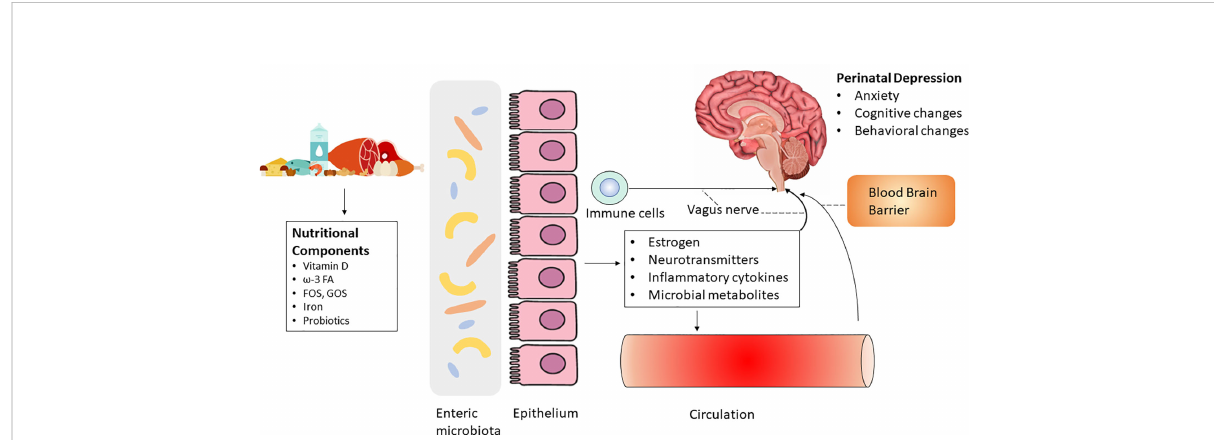
FIGURE 1 Diet and nutrition may regulate perinatal depression via the microbiota-gut-brain axis by in fl uencing systemic biomarkers including estrogen, neurotransmitters, in fl ammatory cytokines and microbial metabolites. The role of probiotics on perinatal depression is